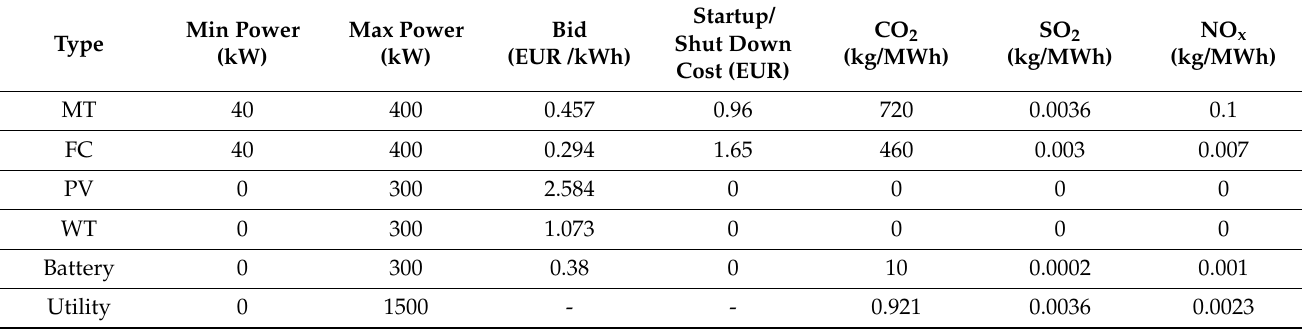
Table 1. The limits and bids of DG sources and the utility grid